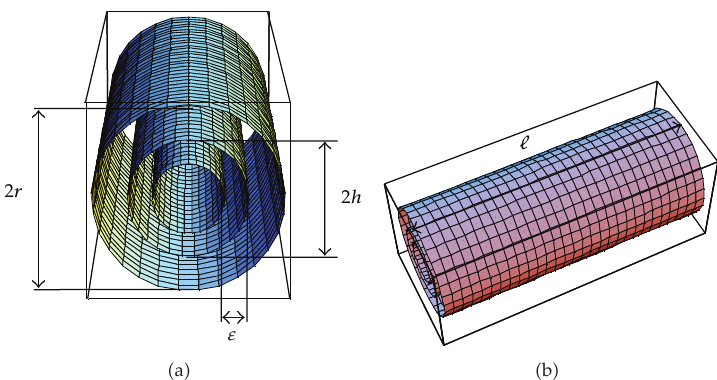
Figure 1: Schematic representations of the axon and its extracellular medium (cid:5) not in scale (cid:6) in the x -axis direction from the input (cid:5) x (cid:10) 0 (cid:6) to the output (cid:5) x (cid:10) (cid:2) (cid:6) sites (cid:5) this figure was produced by the function ParametricPlot3D of the software Mathematica 5.2 developed by Wolfram Research, and Microsoft O ffi ce Power Point (cid:6)